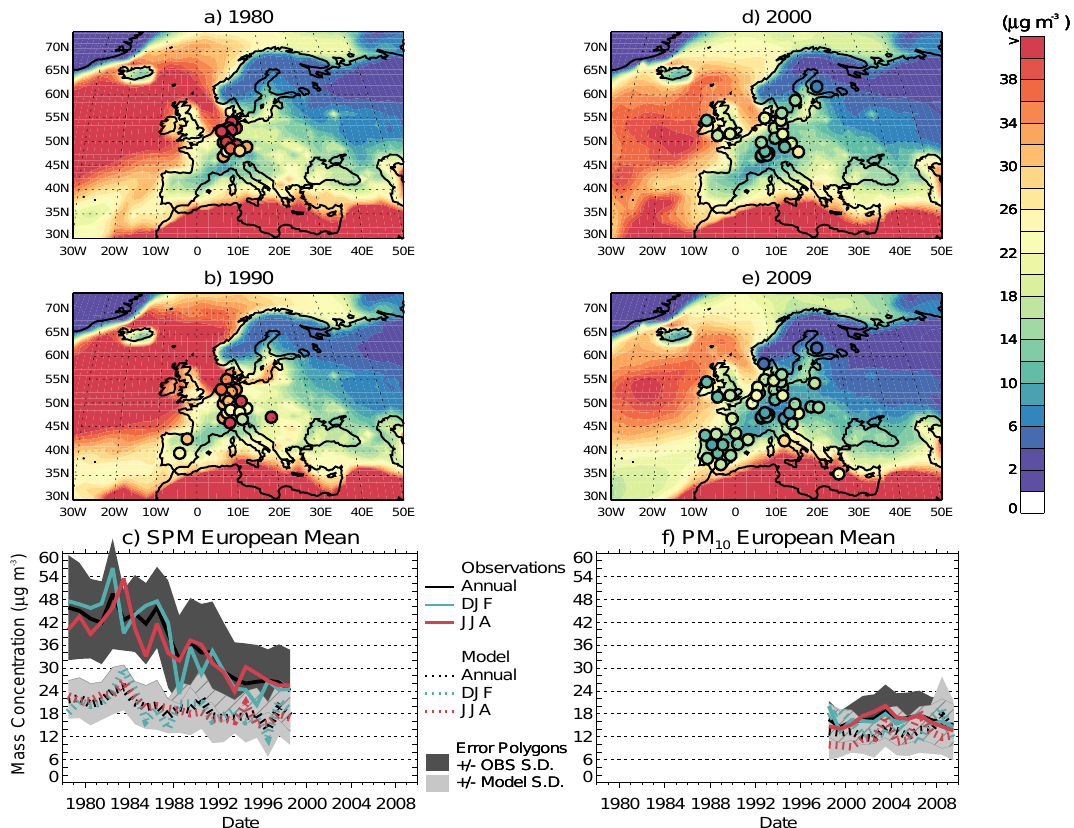
Figure 8. Annual mean SPM mass concentrations (µgm − 3 ) from the lowest model level with observations overplotted in circles for (a) 1980 and (b) 1990. (d) and (e) are the same as (a) and (b) but for PM 10 mass concentrations in 2000 and 2009. A time series of annual and seasonal mean observed (solid lines) and modelled (dashed lines) (c) SPM and (f) PM 10 concentrations averaged across all measurement locations for each particular year. Shaded areas show ± 1 standard deviation of the modelled (light grey) and observed (dark grey) annual mean values, with the hatching identifying areas of